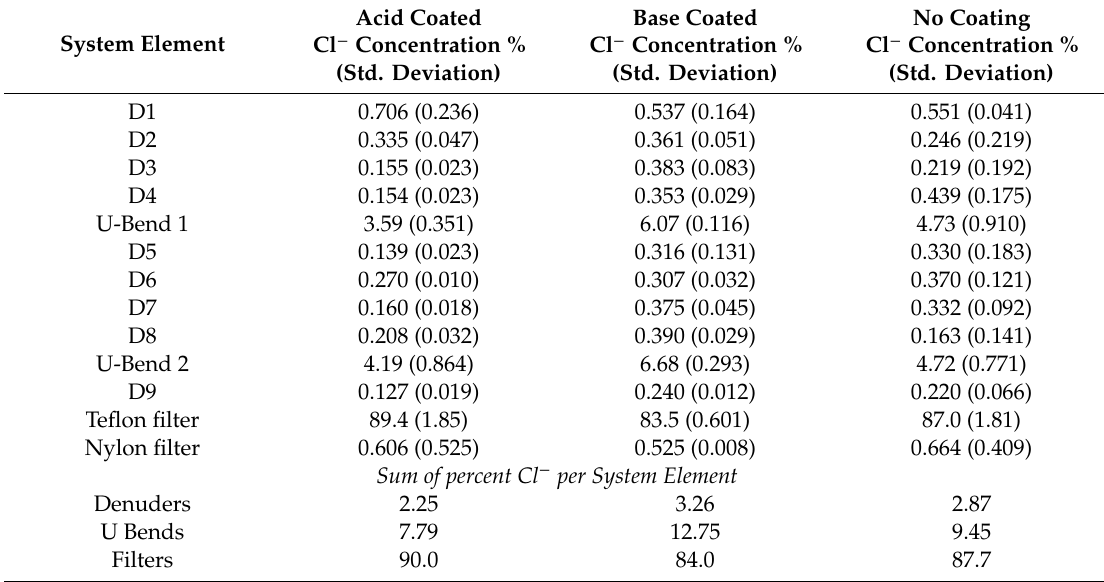
Table 2. Average potassium chloride (KCl) (as Cl − ) concentration percentage of the 9-ADS set-up. The values are given as the average percentage of the three trials conducted per coating treatment type (acid, base, or no coating) for a total of nine trials. The standard deviation is presented in brackets for each of the three coating